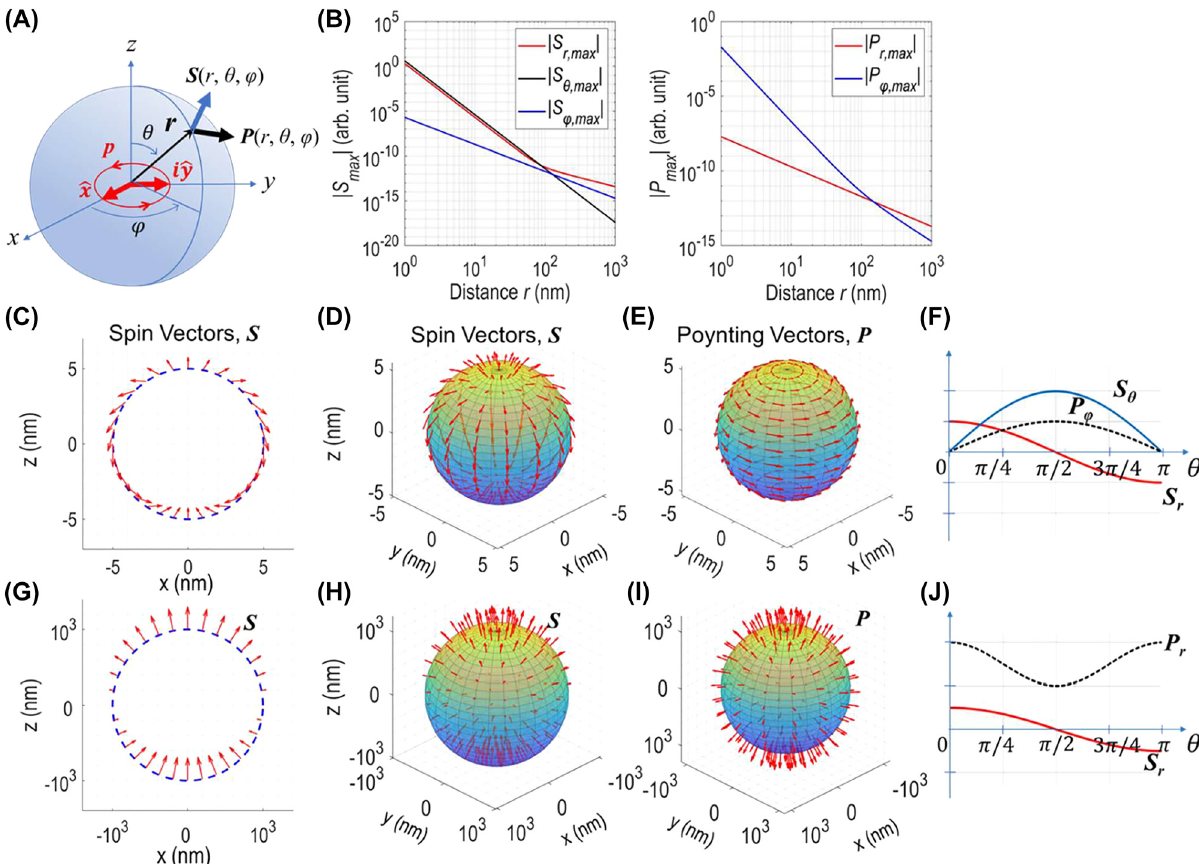
( ) ̂ x + i ̂ y placed at the 2 ) and r